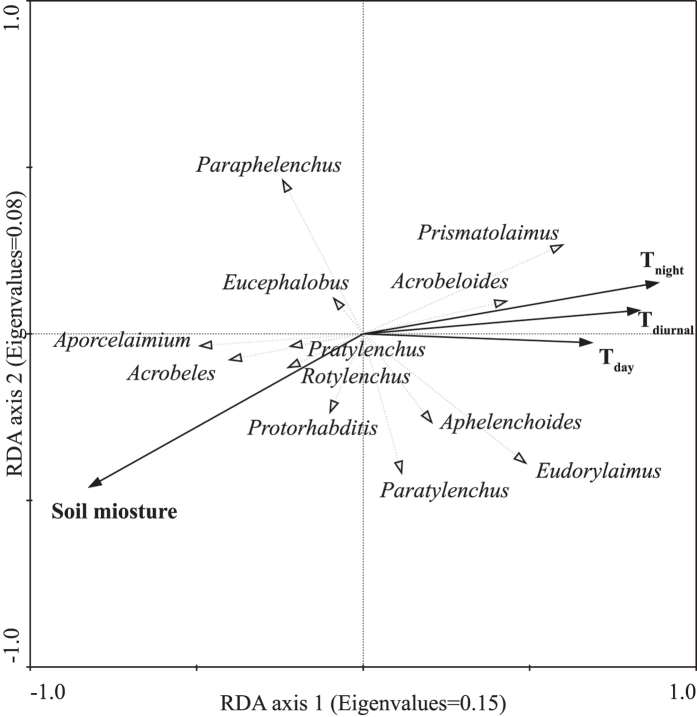
RDA bi-plot of nematode genus and environmental variables.Tnight is average temperature in night-time. Tday is average temperature in daytime. Tdiurnal is daily (24 hour) average temperature. The species-environment correlations were 0.76 for axis 1 and 0.74 for axis 2. The environmental variables explained 27.9% of the total variance in the species data (Soil moisture: 14.6%, p = 0.002; Tnight: 14.4%, p = 0.002; Tdiurnal: 13.3%, p = 0.004; Tday: 11.2%, p = 0.010).